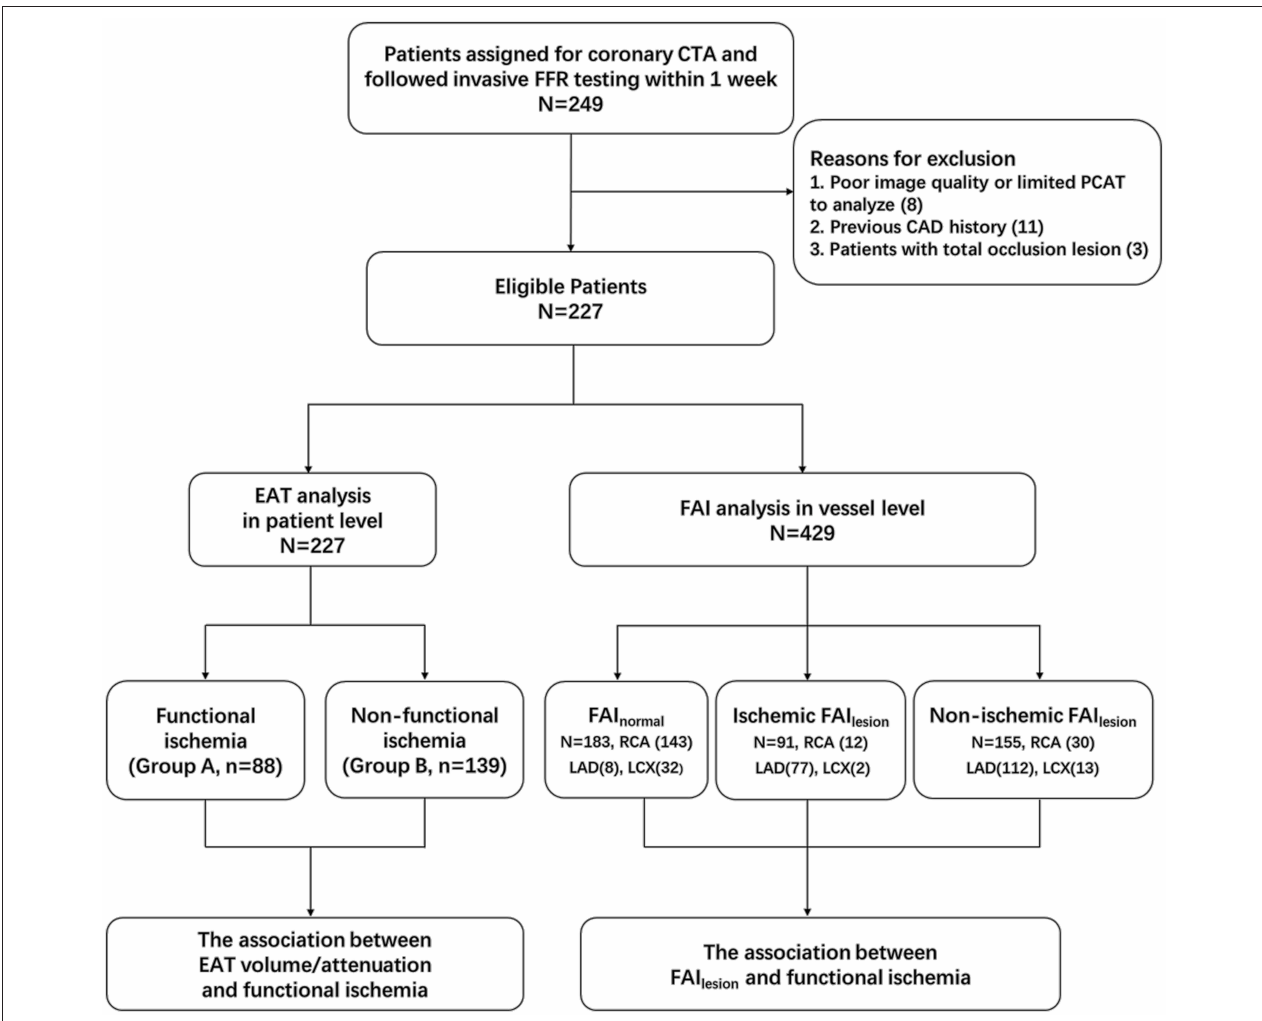
FIGURE 1 | Study design and subjects grouping. CTA, computed tomography angiography; FFR, fractional flow reserve; EAT, epicardial adipose tissue; PCAT, peri-coronary adipose tissue; FAI, fat attenuation index; FAI normal , lesion-free fat attenuation index; FAI lesion , lesion-specified fat attenuation